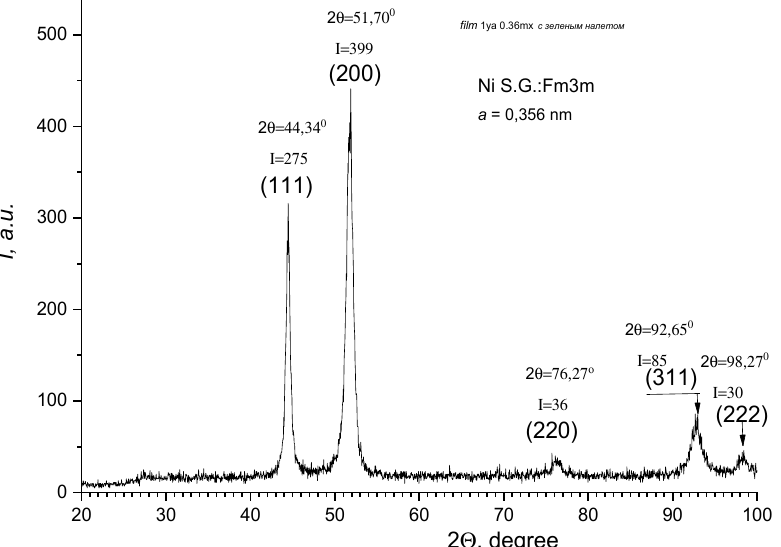
Figure 5. X-ray of el/p film. All reflections on the radiograph are indicated in accordance with cards 04-08950, 88-2326 PCPDFWIN v.2 1998 JCPDS. According to the database card 04-08950, the angular values of these reflections and their intensities are given in Table